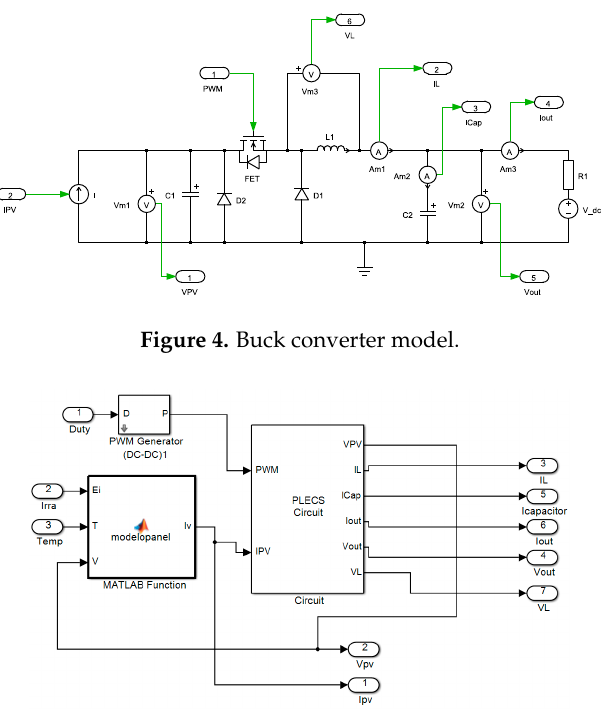
Figure 6. Output voltage of buck converter.